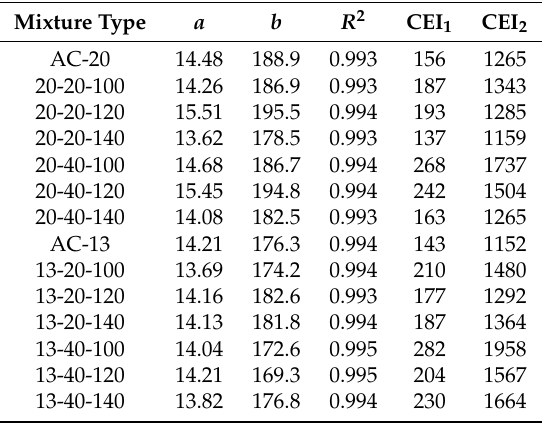
Table 8. Regression results of Equation (2) and the CEI.